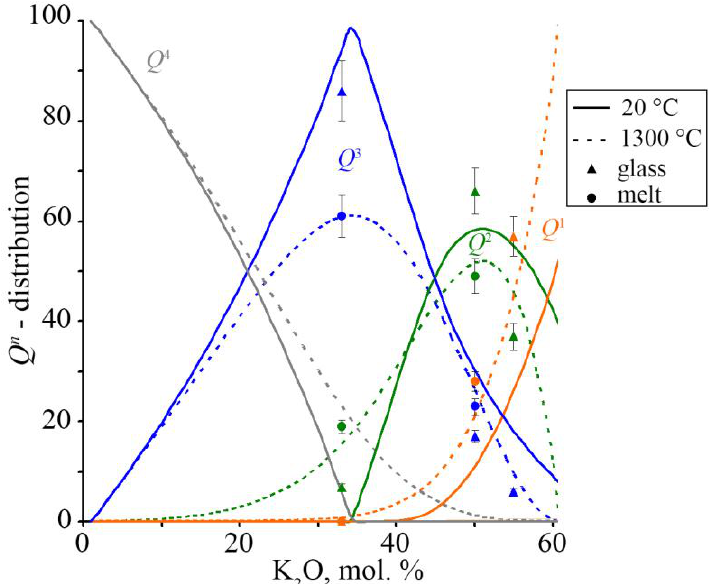
Figure 4. Result of calculated Q n distribution in K 2 O-SiO 2 system at 20 and 1300 °C in comparison with the results of Raman spectroscopy after correction. Points are experimental data. Lines are the results of modeling. Table 1. Vibration frequencies, concentrations of structural units and equilibrium constants of Re- action (1) at n = 3 in glasses and melts of the potassium silicate sample with 33 mole per cent of potassium oxide at various temperatures ( 1 -NMR data [34]).